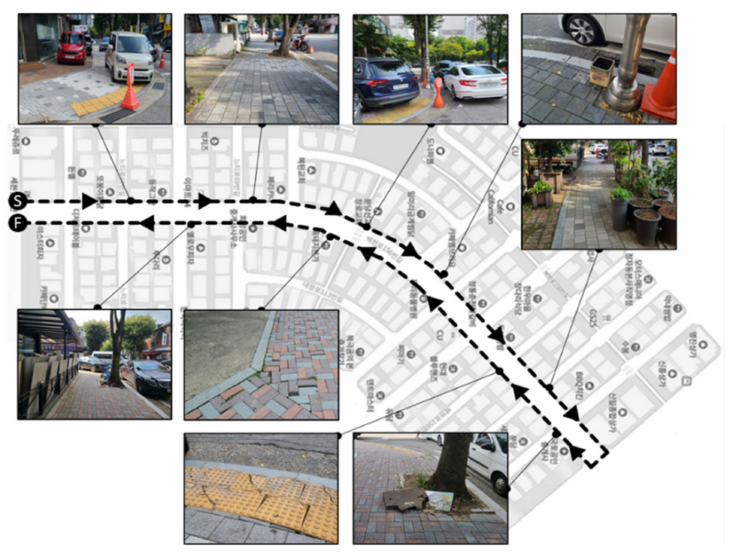
Figure 2. Overview of the experimental site including the path and environmental